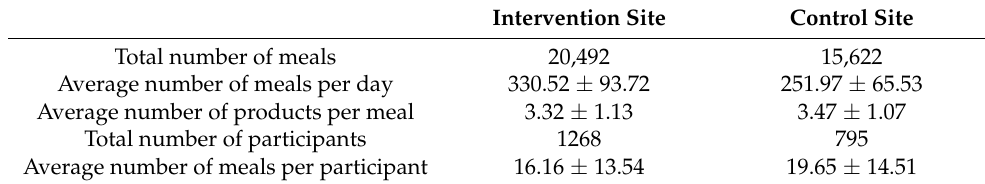
Figure 1. Flow chart of the inclusions in the analysis—Nutri-Score catering trial. The intervention site served more meals on average and in total than the control site, with an average of 330.52 ± 93.72 vs. 251.97 ± 65.53 meals per day during the study period (Table 1). Table 1. Descriptive analysis of the intervention and control sites—Nutri-Score catering